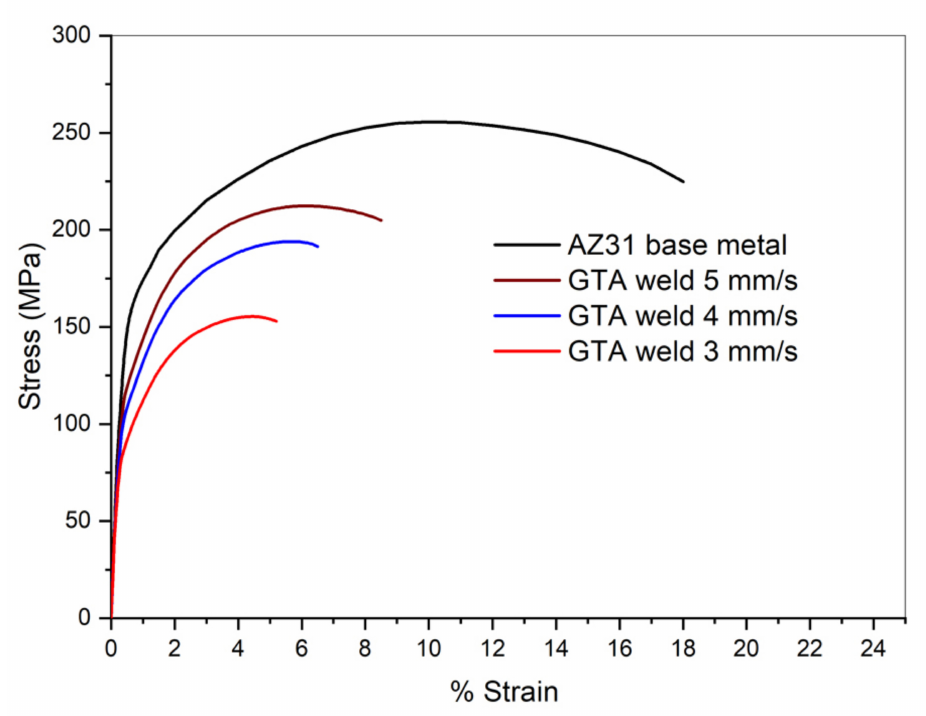
Figure 11. Typical tensile curves for AZ31 base metal and GTA welded joints made at different welded joints (3 mm/s, 4 mm/s, and 5